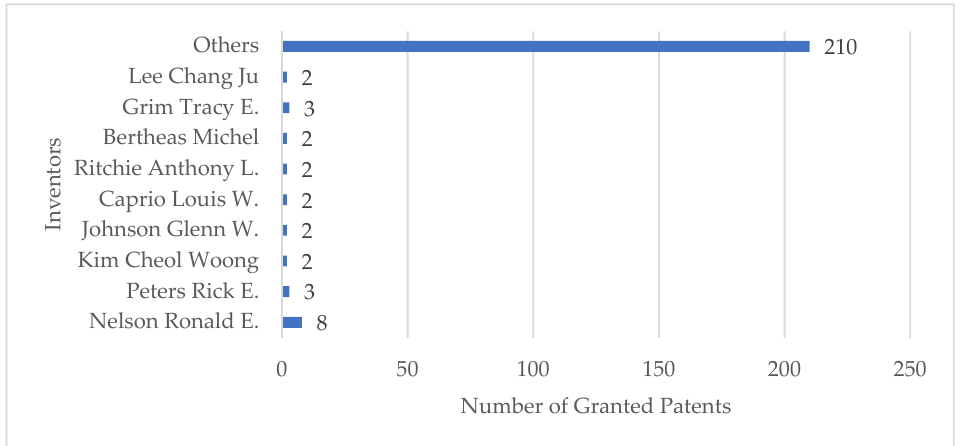
Figure 5. Inventors of granted patents on ankle sprain prevention methods.